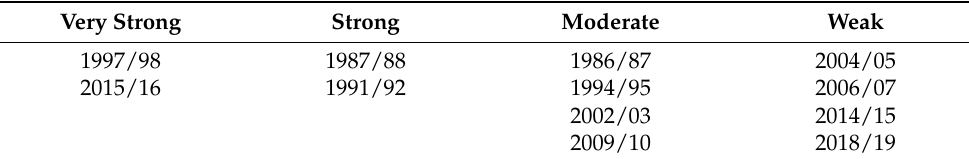
Table 2. Categories of El Niño events occurred during the period of 1986 to 2021. Created with data from [19]. Very Strong Strong